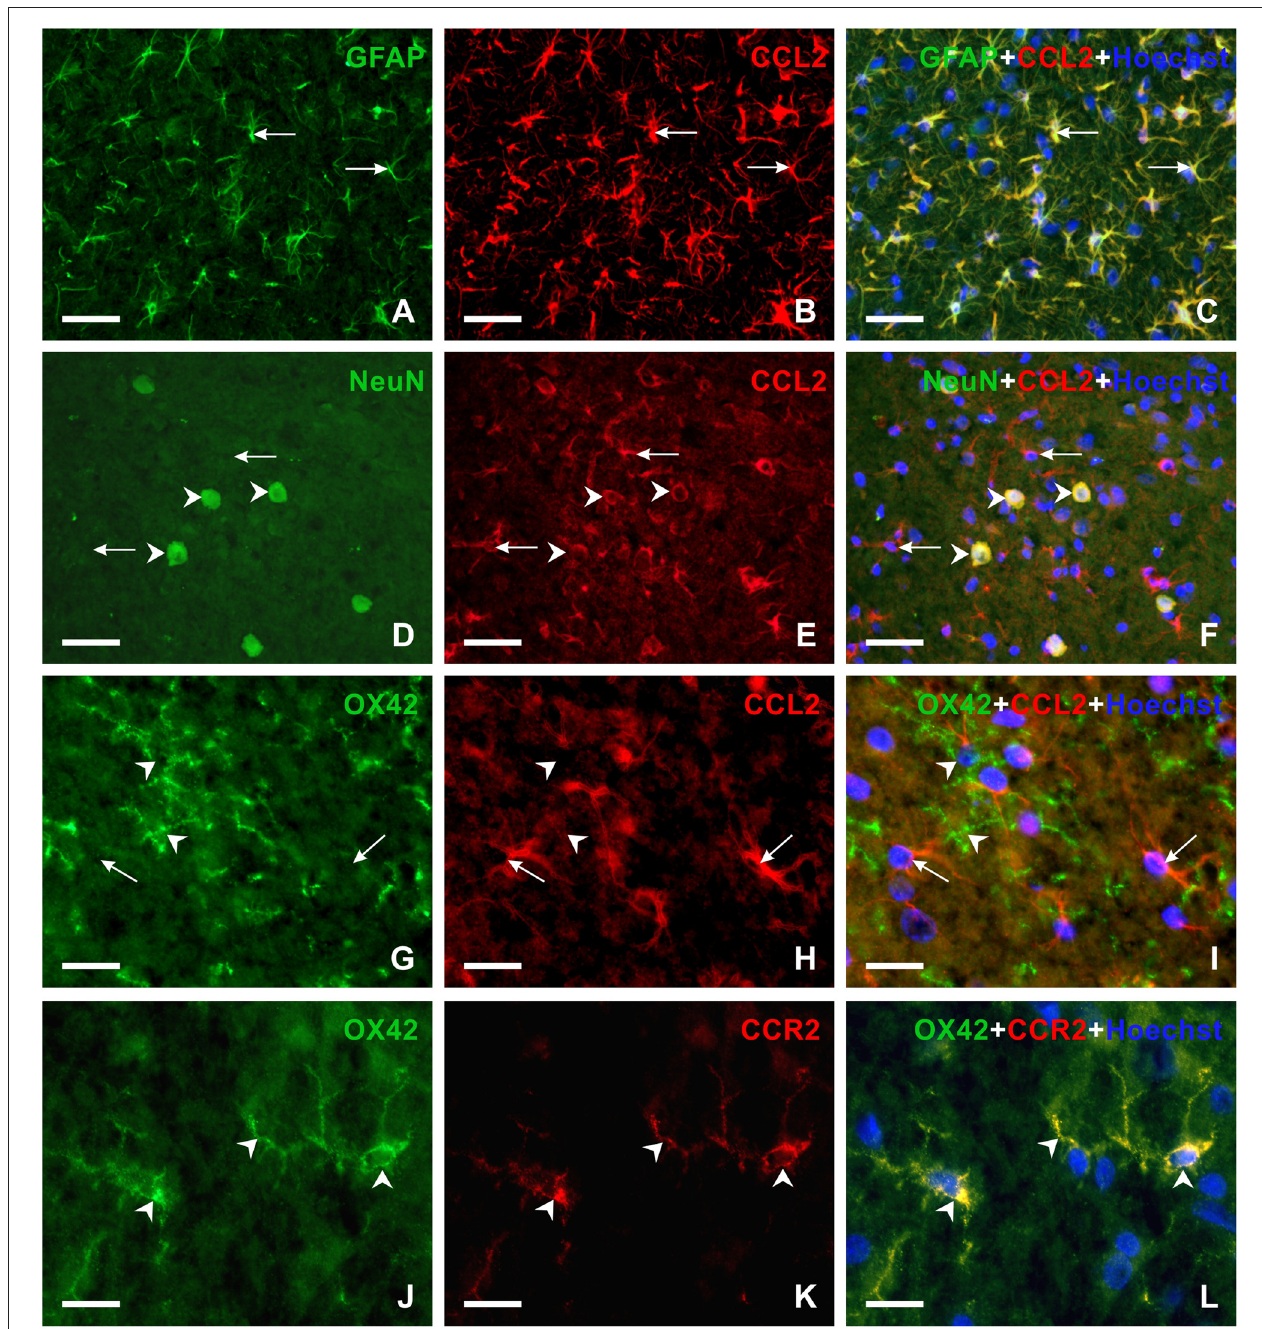
FIGURE 8 | Double immunofluorescence staining in vlPAG of rats 3 weeks from sCCI. (A–F) Sections illustrating double immunofluorescence staining for CCL2 and GFAP or NeuN as markers of activated astrocytes or neurons, respectively. The merged pictures (C,F) show CCL2 protein in activated astrocytes (arrows) and neurons (arrowheads). (G–L) Double immunofluorescence staining for OX42 as a marker for microglial cells and CCL2 (G–I) or CCR2 (J–L) . The merged picture (I) shows the absence of CCL2 protein in microglial cells. Compare CCL2 positive astrocyte-like cells (arrows) with the absence of CCL2 immunoreaction in microglial cells (arrowheads). However, OX42+ microglial cells displayed CCR2 immunostaining (arrowheads in L ). Scale bars = 40 µ m for (A–F) ; 75 µ m for (G–I) ; 15 µ m for (J–L) .